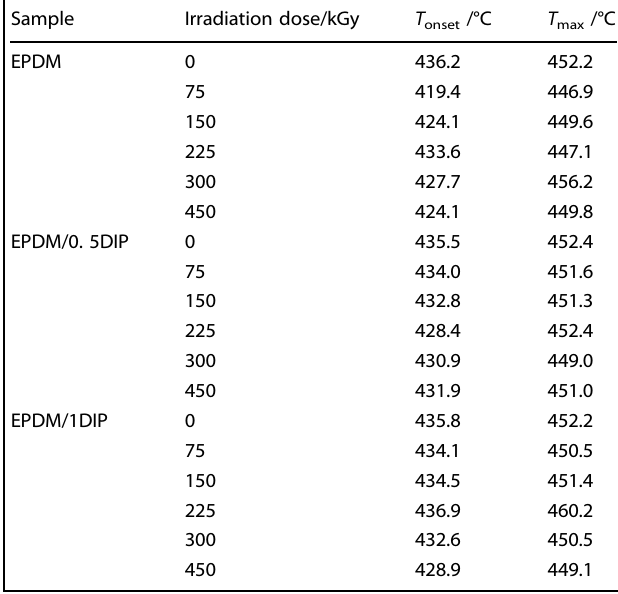
Table 1. TG data of the samples with different blend compositions subjected to different γ -irradiation doses.